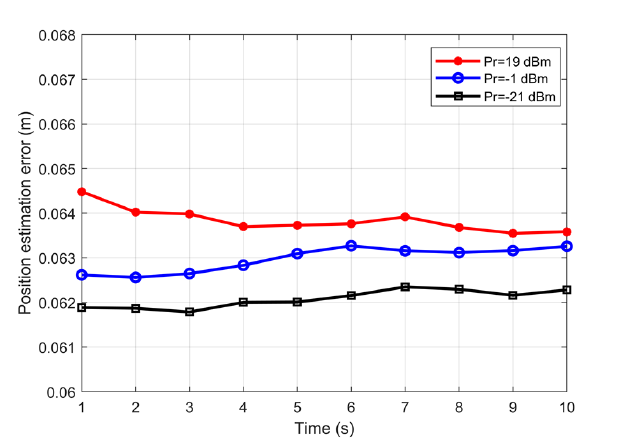
Figure 3. The estimated position error as a function of time for different power levels using a Kalman filter, assuming an ideal source.